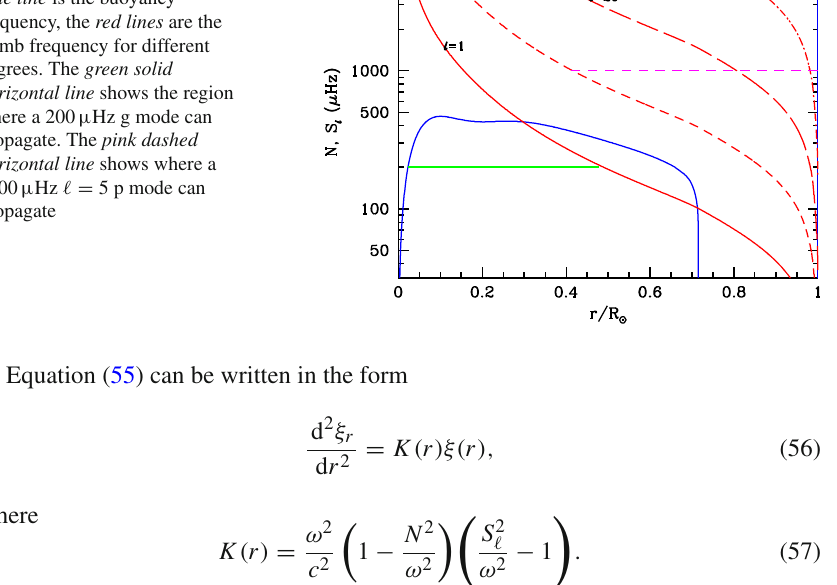
Fig. 1 The propagation diagram for a standard solar model. The blue line is the buoyancy frequency, the red lines are the Lamb frequency for different degrees. The green solid horizontal line shows the region where a 200 µ Hz g mode can propagate. The pink dashed horizontal line shows where a 1000 µ Hz (cid:2) = 5 p mode can